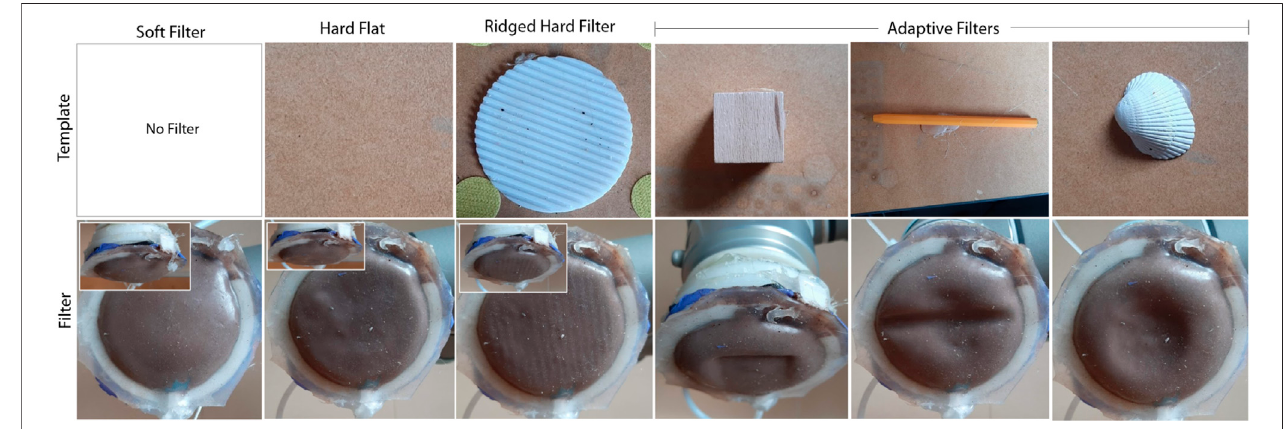
FIGURE 3 | Examples of template structures and the corresponding deformation pattern of the fi lter when the online adaption of the fi lter is performed.